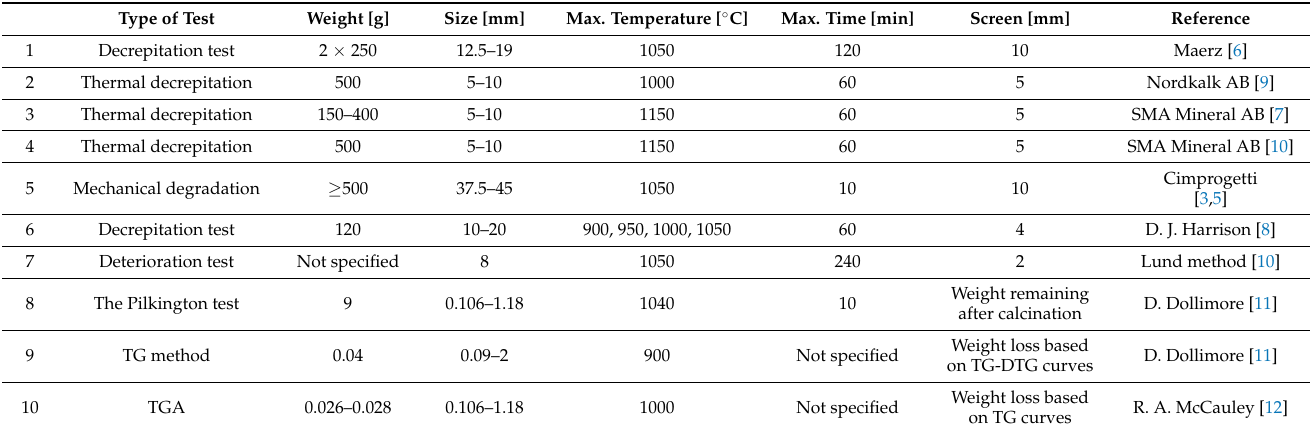
Table 1. Thermal decrepitation evaluation